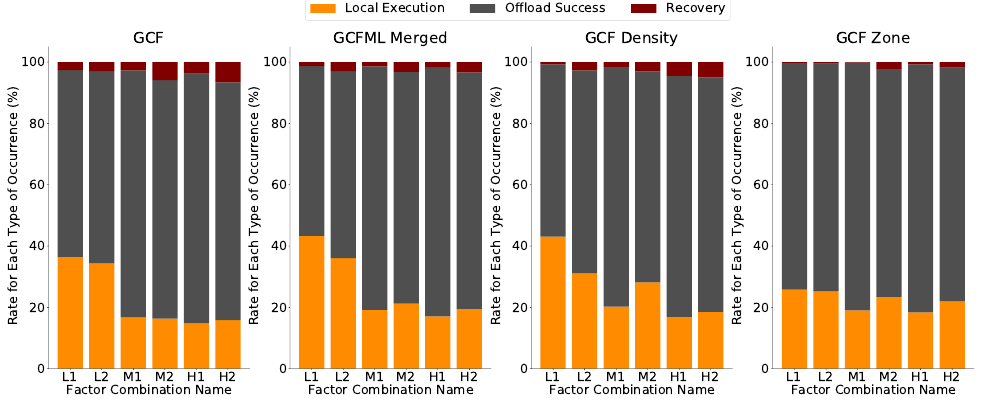
Figure 11. Comparison of offloading completion rates across all